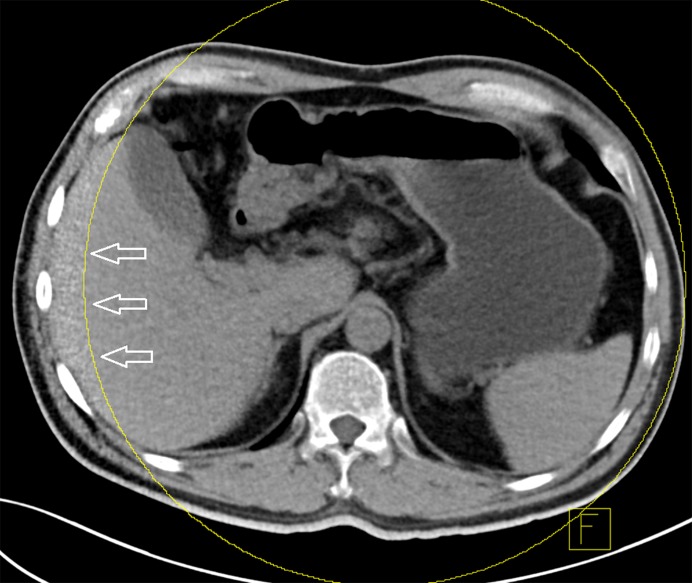
Excluded relevant anatomy.The yellow circle relates to the smaller (33 cm) field of view of the smaller detector. Iodine maps and subsequent iodine subtraction to create the virtual non-enhanced images can only be performed within the circle. In larger patients (>40 cm actual body diameter) or patients with improper position important anatomy may be excluded from the subtraction. In this example the lateral aspect of the right lobe of the liver fails to ‘become unenhanced’ (arrows).